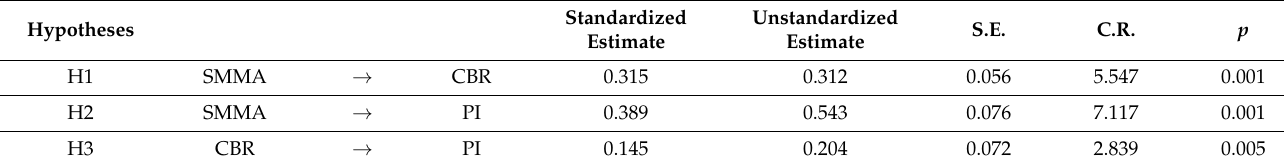
Table 6. Result of the SEM